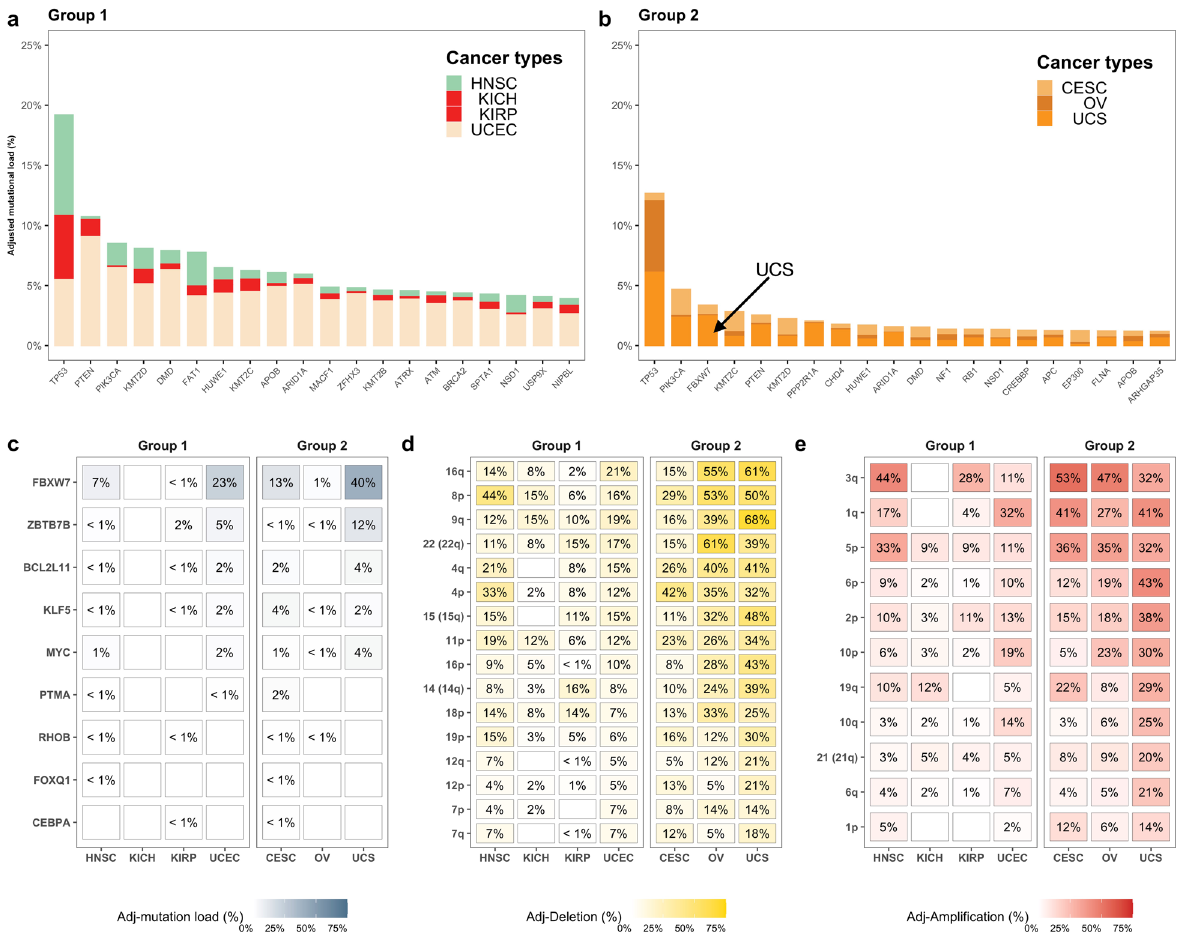
Fig. 4 Most highly mutated genes and chromosomal arm-level aberrations in Groups 1 and 2. The cancer types with the highest and lowest BC-CCS were placed into two groups: Group 1 = HNSC, KICH, KIRP and UCEC; Group 2 = CESC, OV and UCS. a The top 20 most mutated cancer driver genes for Group 1 and b Group 2, mutation percentage has been adjusted for sample number within each cancer type for all genes individually. c Driver genes with a higher mutation level in Group 2 relative to Group 1 by Fisher ’ s-exact Test. d Chromosomal arm-level deletions that occur with higher frequency in Group 2 relative to Group 1 and e chromosomal arm-level ampli fi cations occurring with higher frequency in Group 2 relative to Group 1. All comparisons were adjusted for multiple